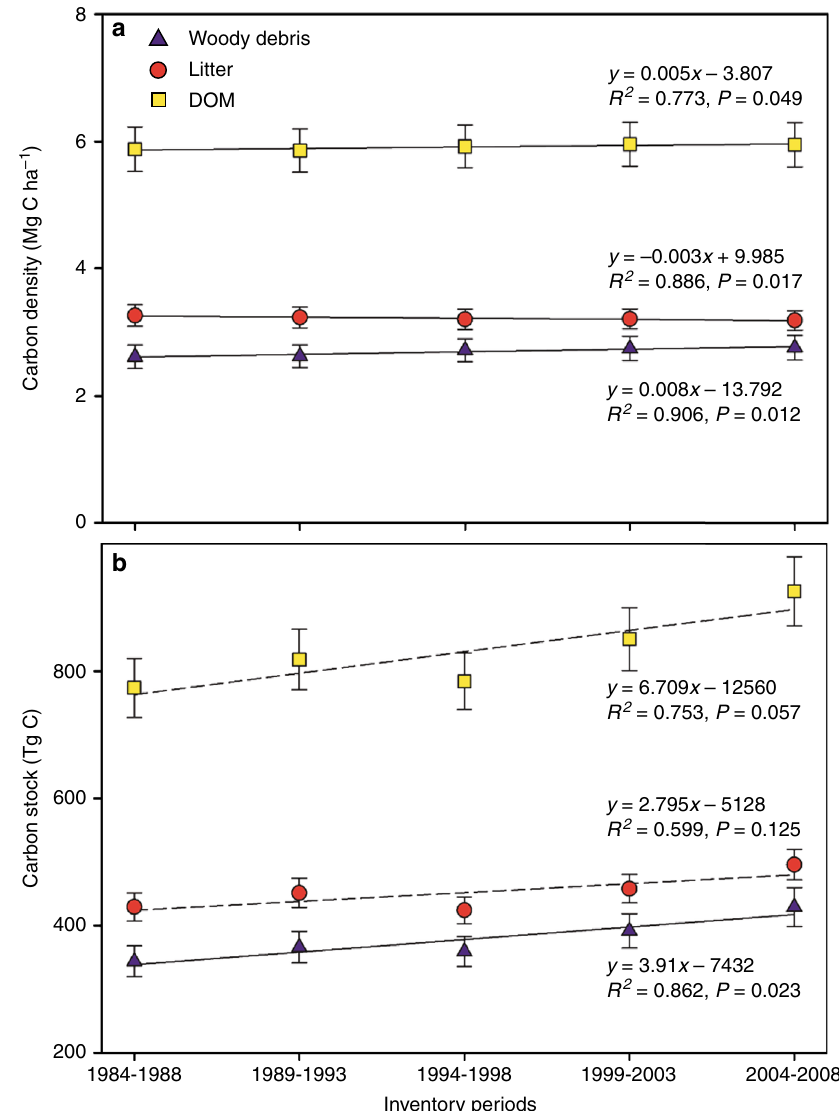
Fig. 5 Changes in dead organic matter carbon over the past two decades. Changes in dead organic matter a carbon density and b carbon stock in China's forests from 1984 – 1988 to 2004 – 2008. Carbon densities and stocks are presented as means ± 1 SD, generated by 500 resamplings. The fi tted lines are from linear regression. Signi fi cant fi tted lines ( P < 0.05) are shown as the solid lines, and non-signi fi cant fi tted lines ( P > 0.05) are shown as the dotted